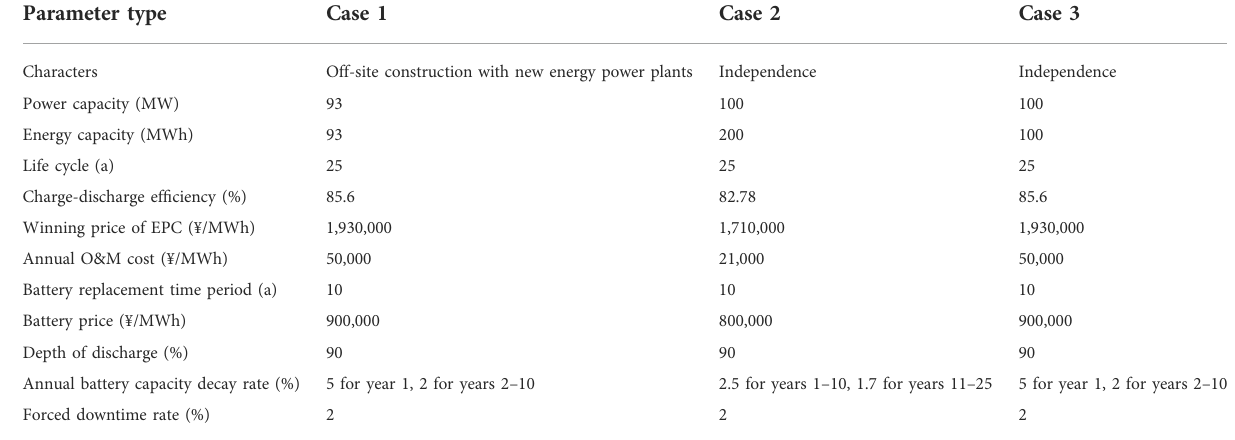
TABLE 1 Basic parameters of independent energy storage